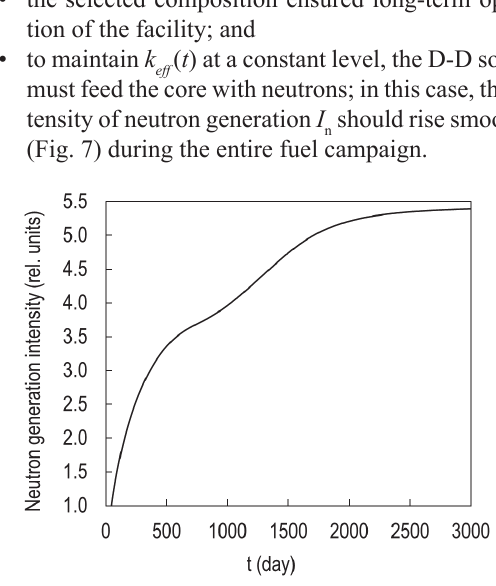
Figure 7. Increase in the GDT-FNS neutron production rate de- pending on the operating time of the fusion-fission